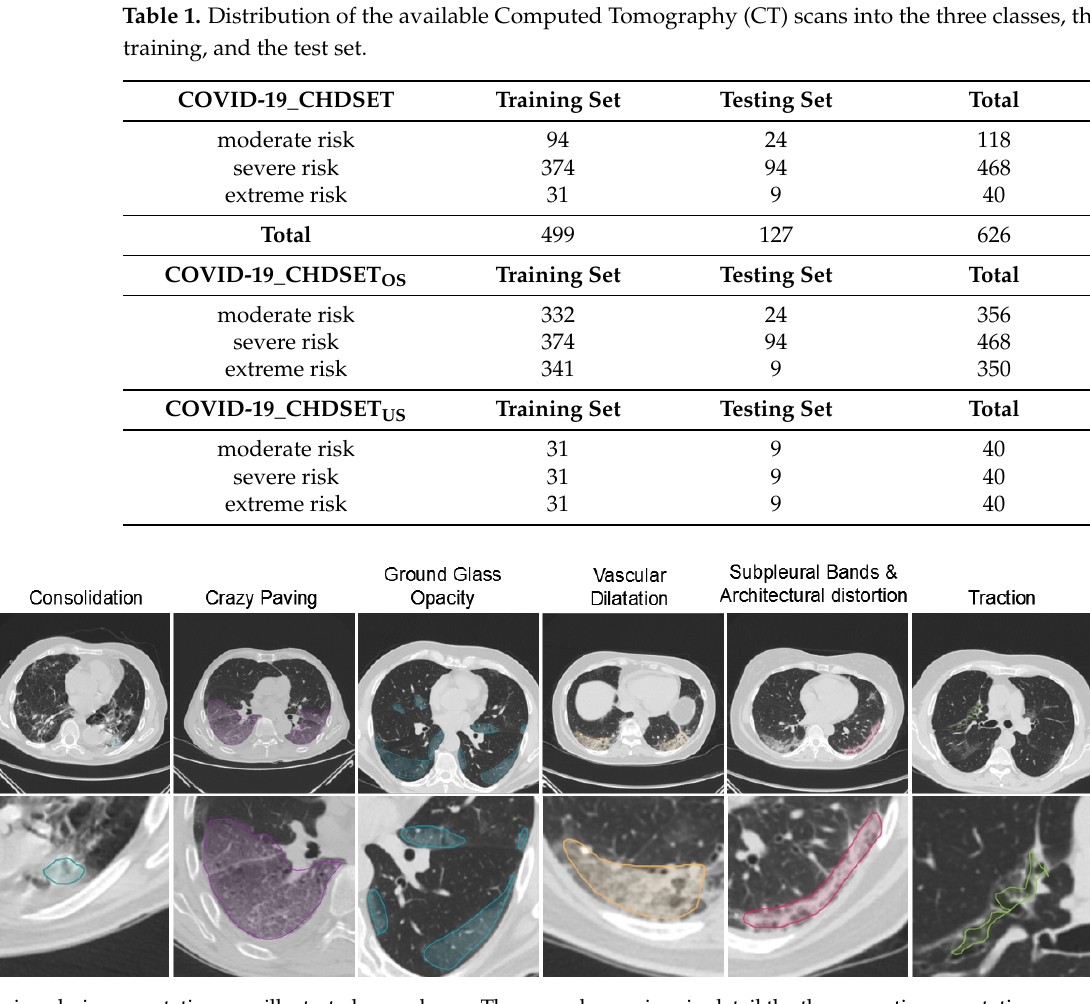
Figure 1. The various lesion annotations are illustrated per column. The second row gives in detail the the respective